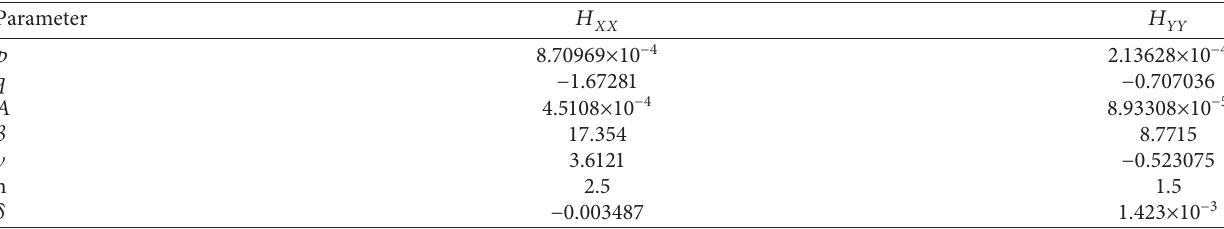
Table 1: Parameter identification results of the hysteresis model in the X - and Y -direction.